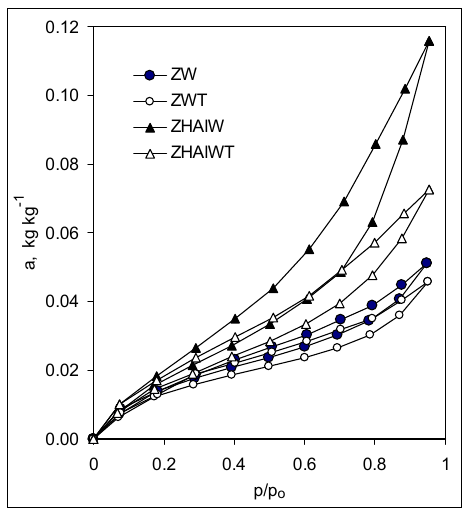
Figure 2. Exemplary adsorption–desorption isotherms. Abbreviation of the samples as in Figure 1. Table 1. Specific surface area (S), fractal dimension (D), adsorption energy (Ea), mesopore volume (v), average mesopore radius (r), and isoelectric point (IEP) of the modified zeolites.